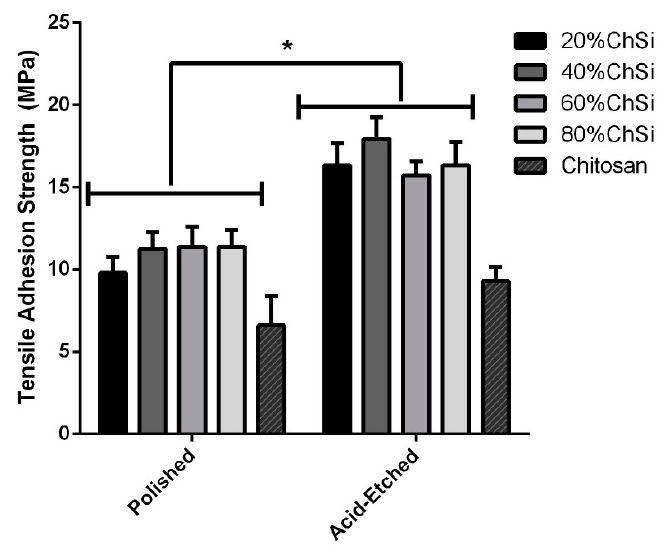
Figure 11. Adhesive tensile strengths of coatings and chitosan on titanium (Ti6Al4V) substrates. All hybrid coatings ( n = 3/surface) had significantly ( p < 0.05) more adhesion to acid-etched than to polished Ti6Al4V substrates. All hybrid coatings were more adhesive than pure chitosan to both polished and acid-etched Ti6Al4V. *—statistically significant difference